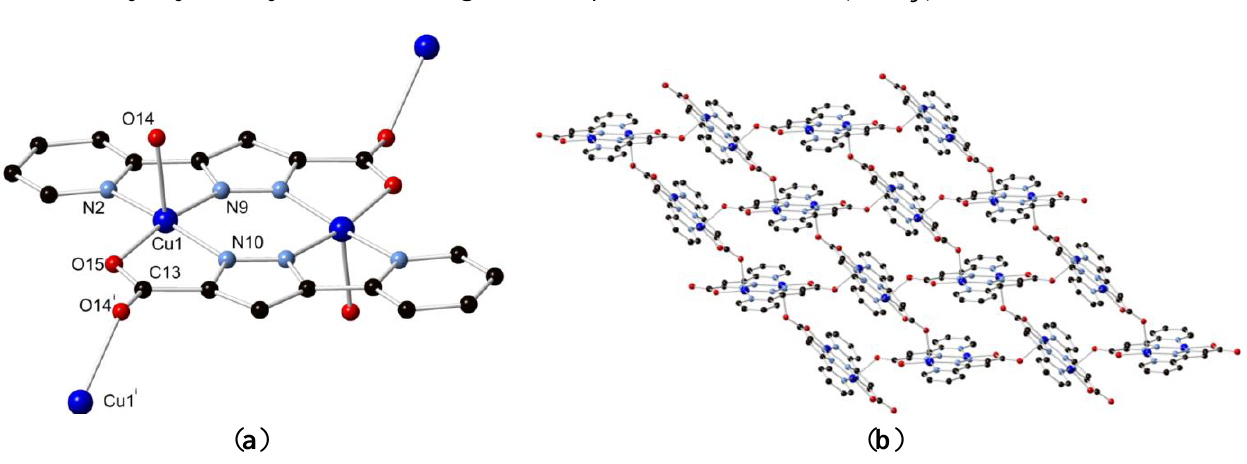
Figure 4. ( a ) Structure of 2 with partial atom labelling scheme; ( b ) the polymer formed by bridging carboxylate linkages between adjacent dimers. Hydrogen atoms are omitted